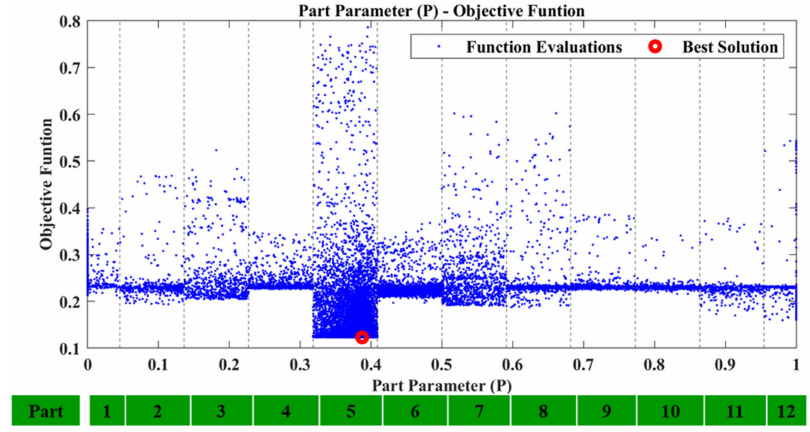
Figure 19. D5: Part parameter (P) versus the Objective Function values.